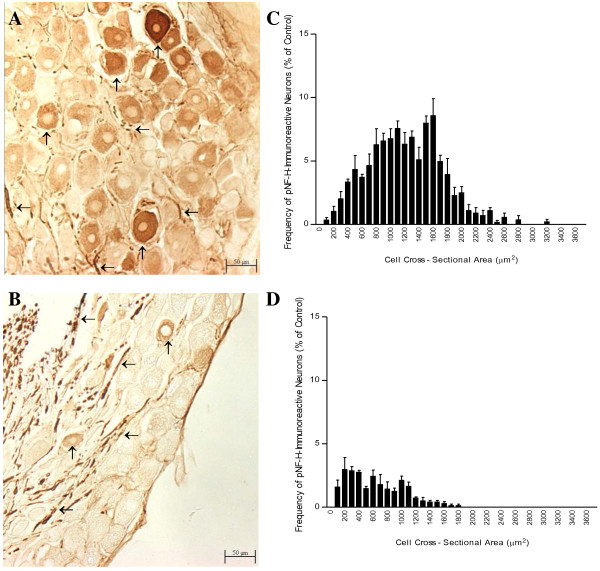
Loss of neuronal pNF-H immunoreactivity induced by oxaliplatin in rat DRG tissue. Photomicrographs (A, B; magnification: 100×) and cell body size frequency histograms (C, D) of pNF-H-immunoreactive L5 DRG neurons from rats treated with the control vehicle (A, C) or oxaliplatin (B, D). Oxaliplatin reduced pNF-H immunostaining of neuronal cell bodies (↑) without changing pNF-H immunoreactivity of ganglionic nerve fibers (←). Cell body size frequency histograms of pNF-H-immunoreactive neurons were altered by oxaliplatin. Bars represent the mean and standard error of the mean for 4 animals.